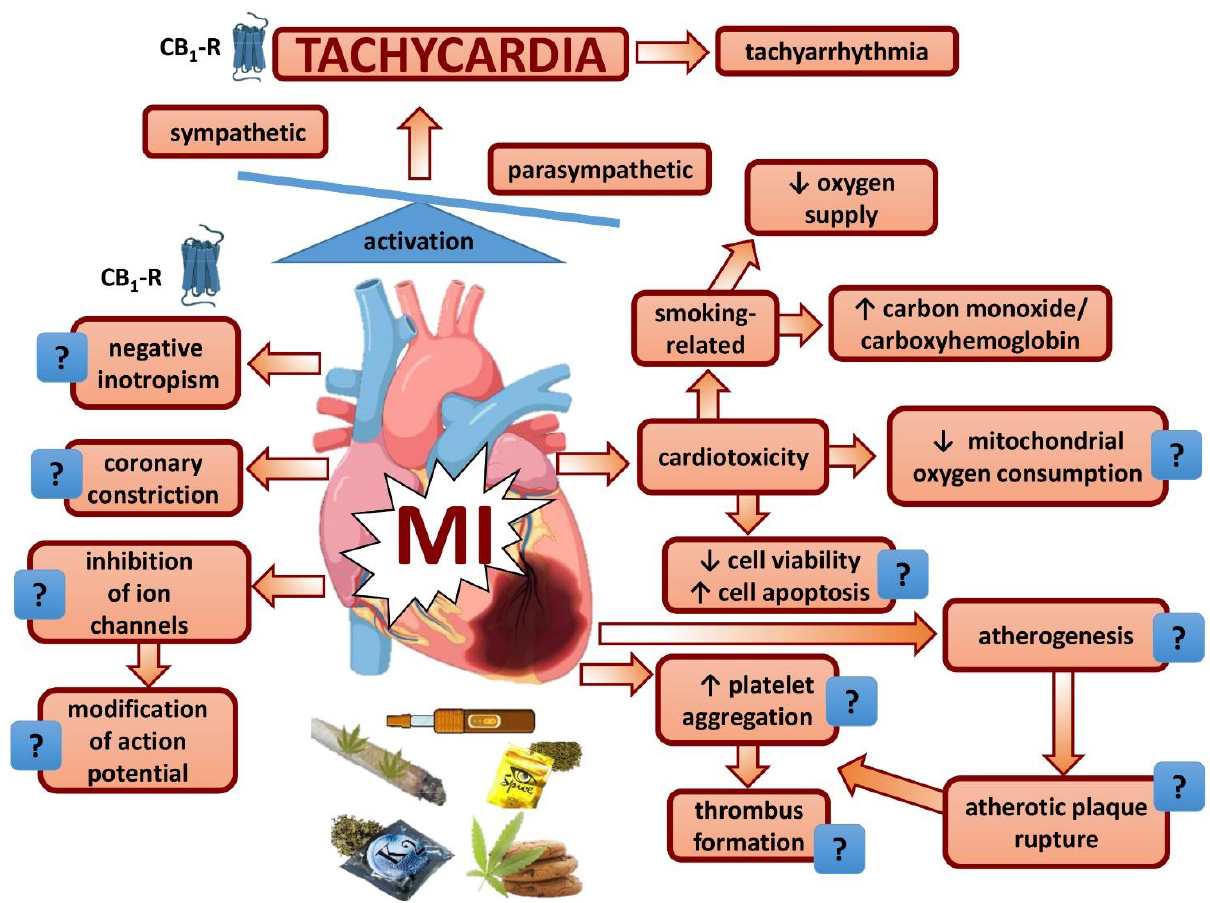
Figure 2. Effects of cannabinoids on the heart possibly implicated in myocardial infarction. ?, pathophysiological relevance plausible but not supported by appropriate studies; CB 1 -R, cannabinoid CB 1 receptor; MI, myocardial infarction.